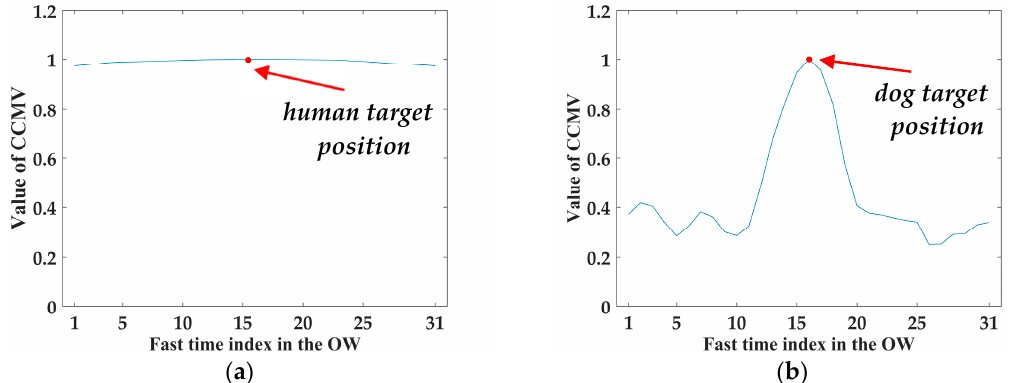
Figure 6. Comparison results of the correlation coefficient of micro vibration ( 𝐶𝐶𝑀𝑉 ) of human targets and dog targets: ( a ) 𝐶𝐶𝑀𝑉 of human targets; ( b ) 𝐶𝐶𝑀𝑉 of dog targets.